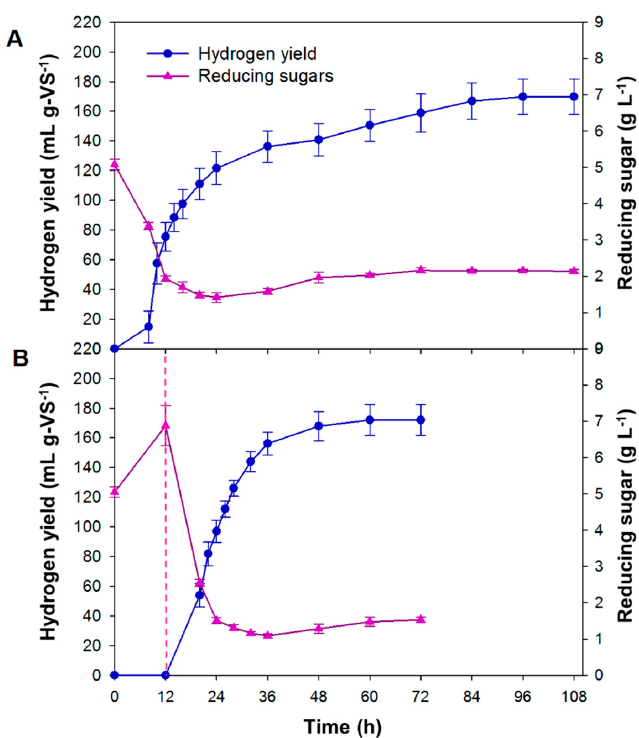
Figure 3. Profiles of reducing sugars and bio-hydrogen during the course of SSF ( A ) and PSSF ( B ) at a Chlorella sp. biomass concentration of 20 g L − 1 . The dotted line in ( B ) indicates the pre-hydrolysis period.